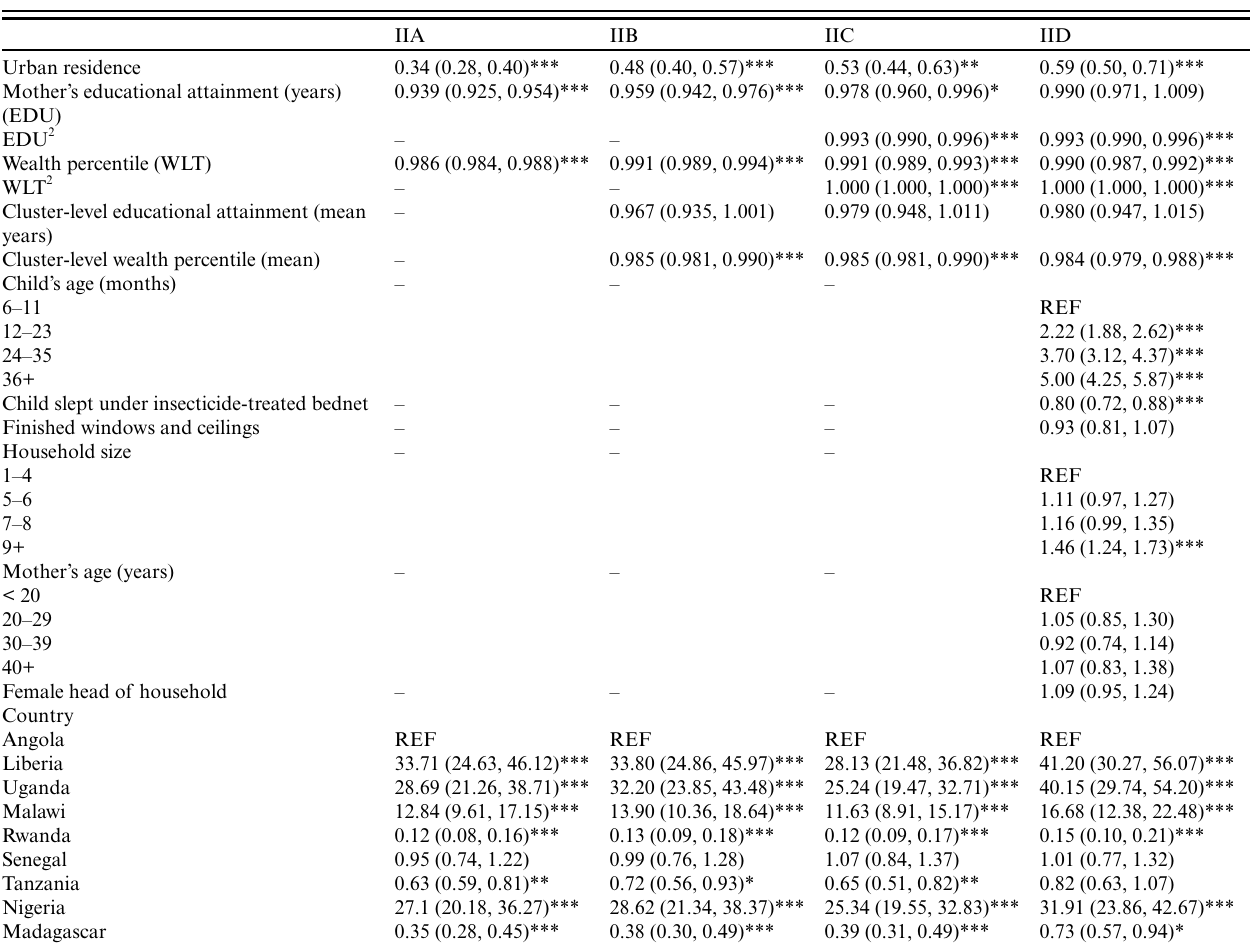
Table 6 . Odds ratios and confidence intervals for malaria parasitemia in children from global hierarchical logistic regression models: minimal (IIA), incorporating cluster-level socioeconomic status factors (IIB), incorporating higher order terms (IIC), and full, incorporating all covariates